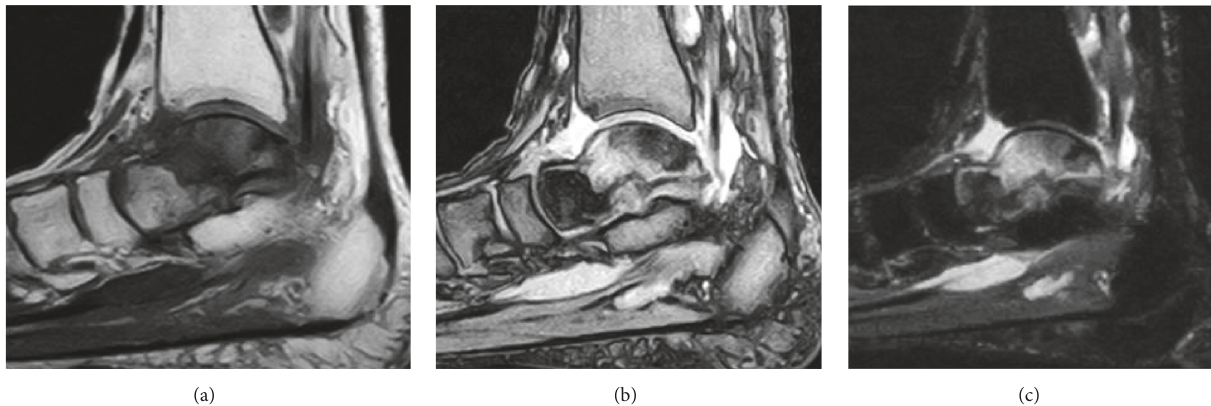
Figure 3: Preoperative MRI scans showing heterogeneous low signal intensity in the talar body on a T1-weighted image (a), low signal intensity in the talar neck and weight-bearing area of the talar body on a T2-weighed image (b), and heterogeneous high signal intensity in the talar body on a STIR image (c).